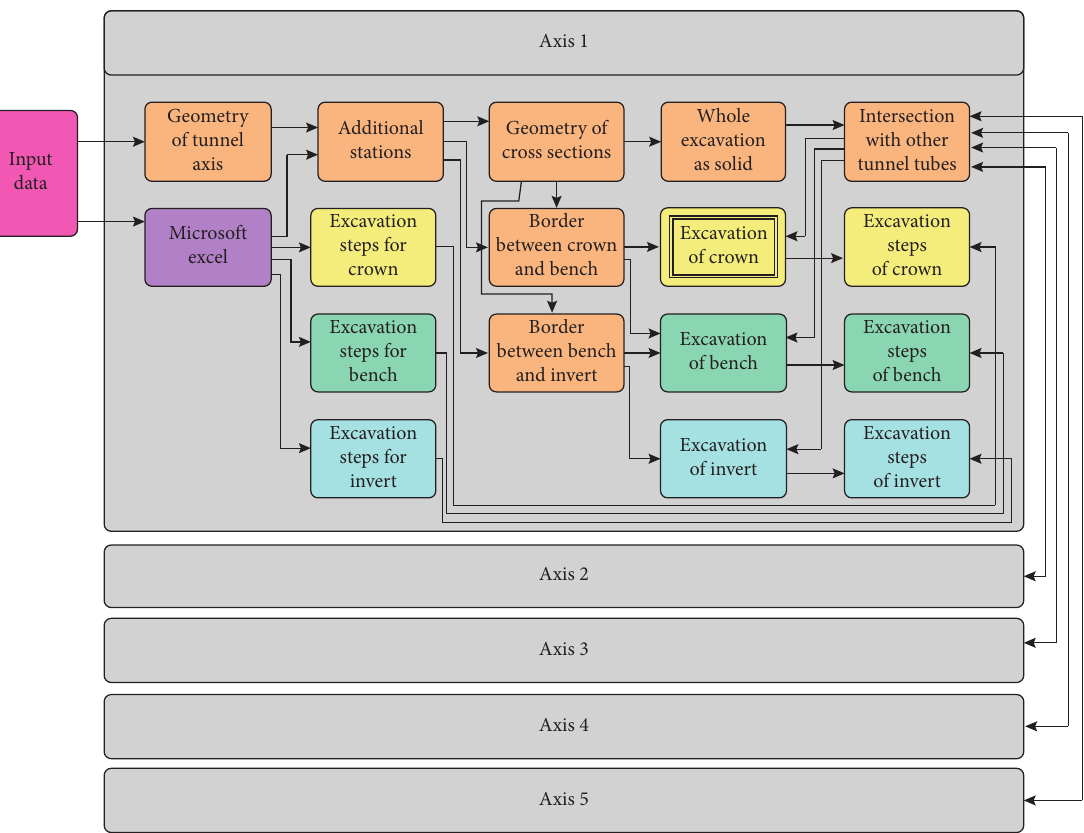
Figure 9: Dynamo script algorithm